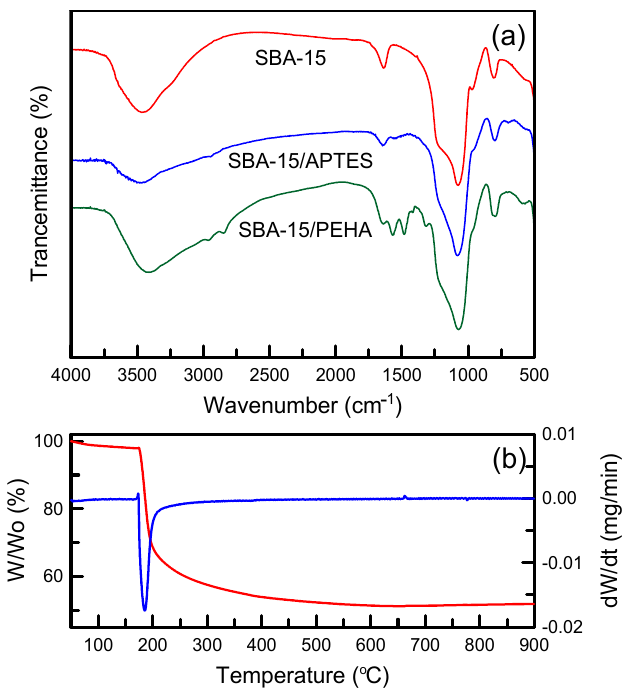
Figure 4. ( a ) FTIR spectra of unfunctionalized and amino-functionalized silica samples; ( b ) TG and DTG thermograms of uncalcined SBA-15